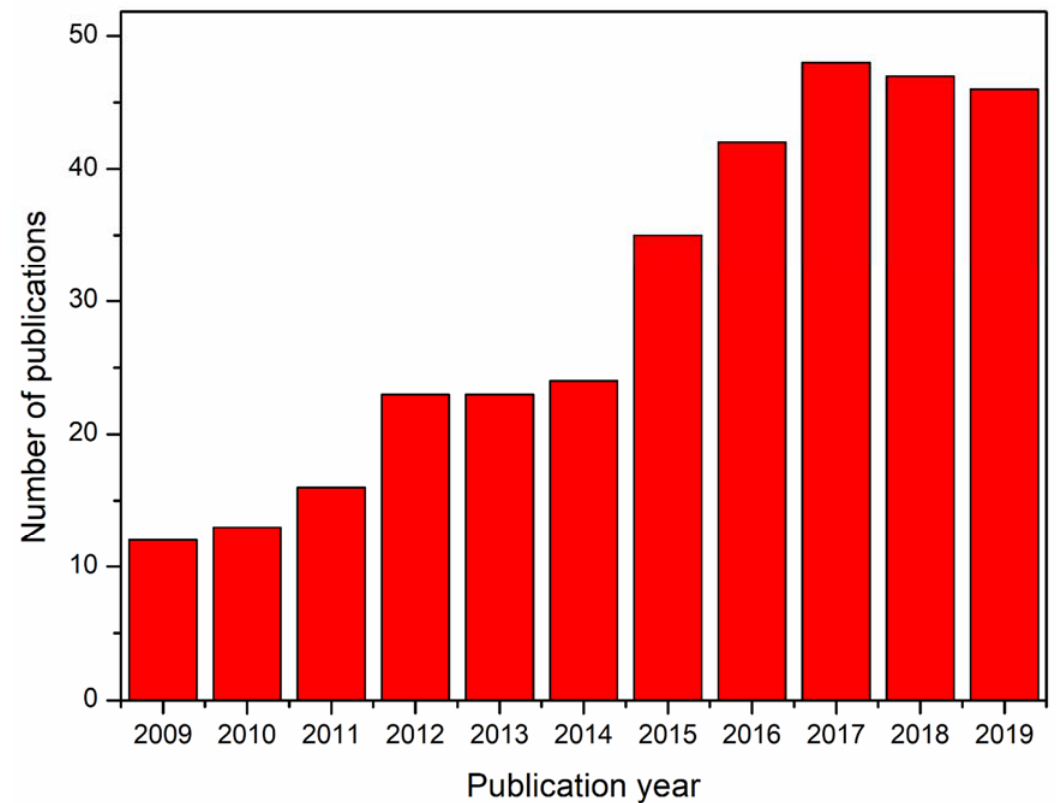
Figure 1. Illustration of the annual number of scientific publications since 2009.